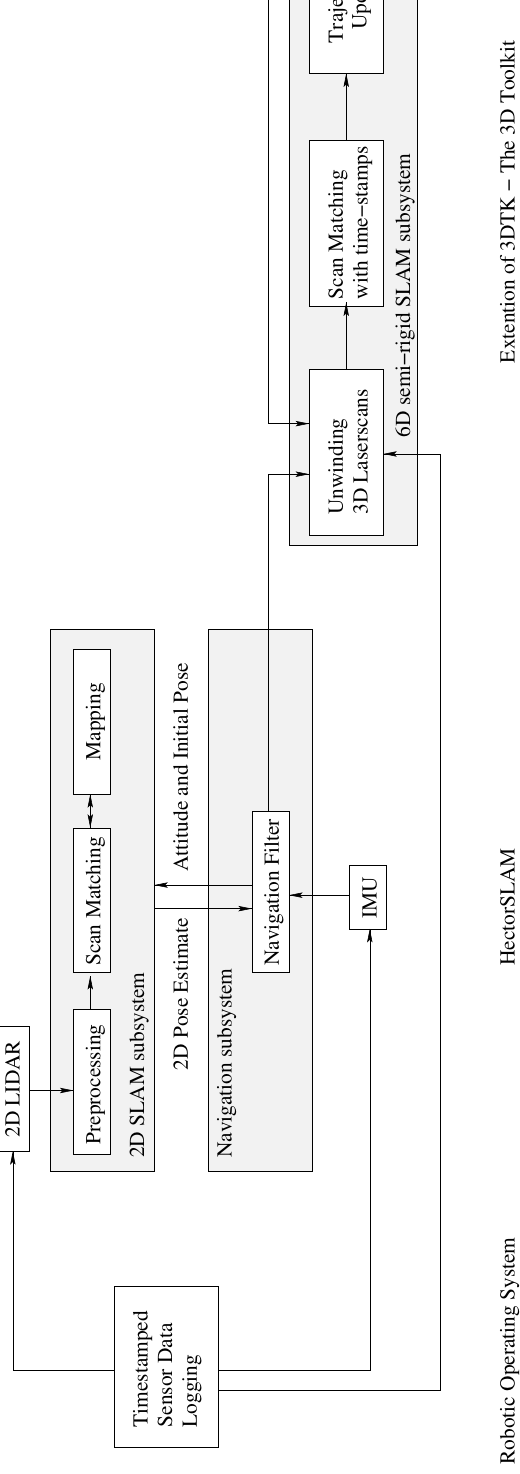
Figure 2. Overview of the system